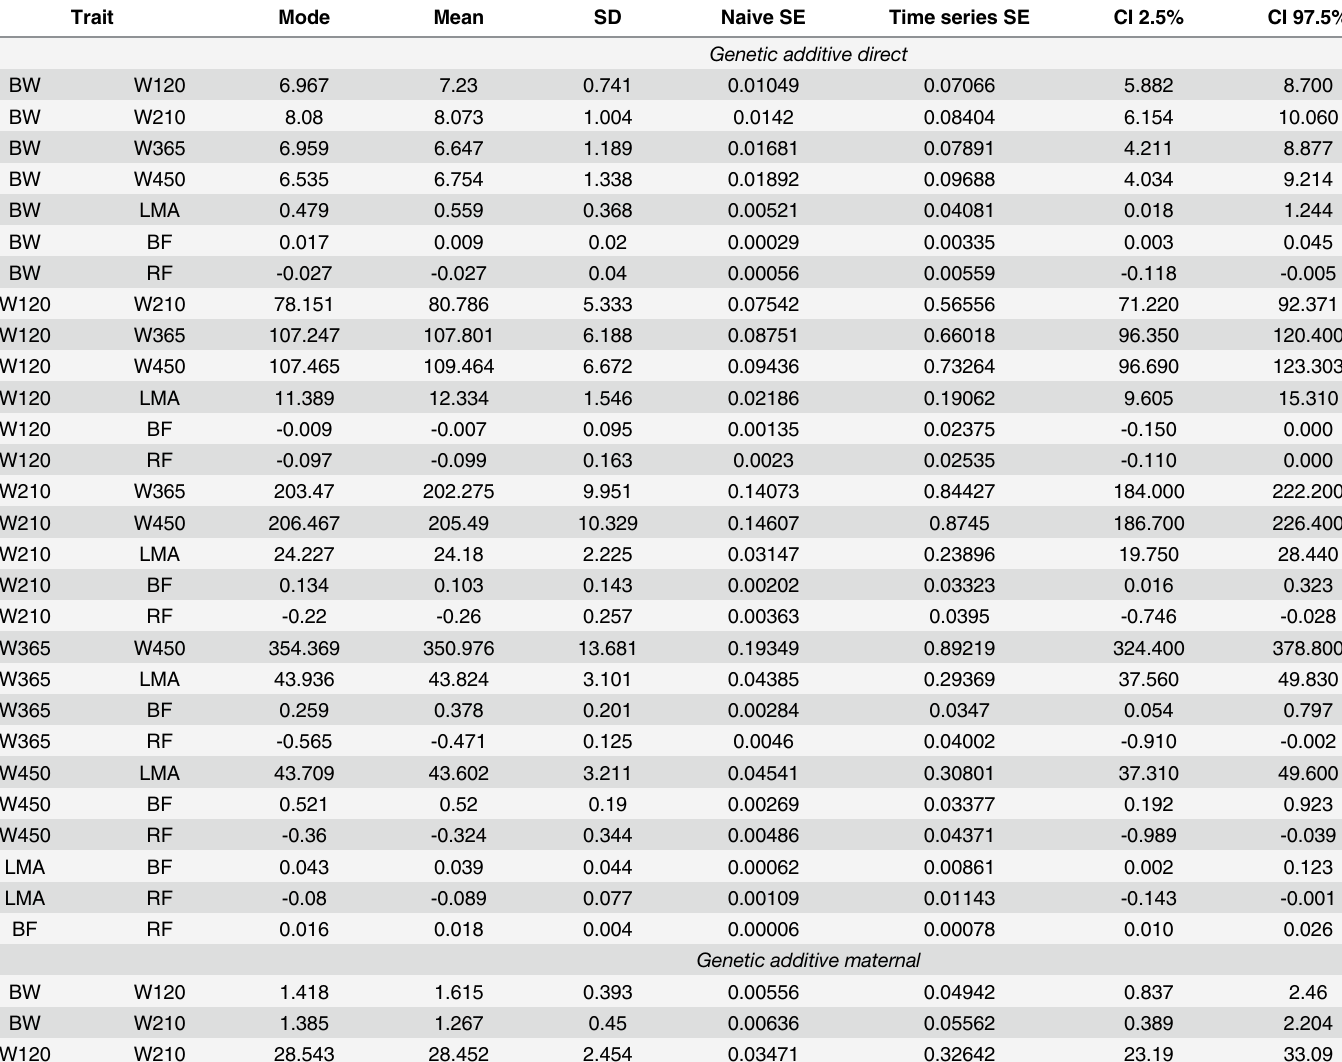
Table 3. Marginal posterior distributions of the genetic covariances among growth and carcass traits in Polled Nellore cattle.